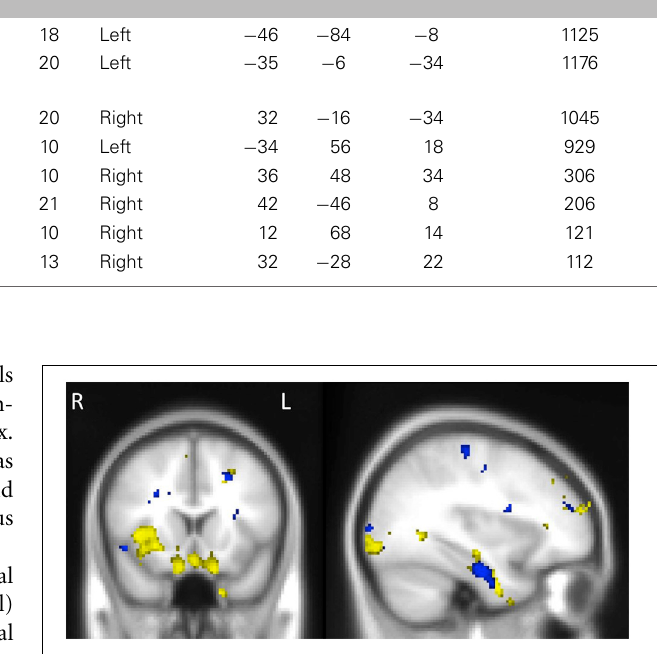
FIGURE 5 | Voxel-based morphometry results showing regions that correlate with emotional enhancement of memory in bvFTD (yellow) and AD (blue). Colored voxels show regions that were significant in the analyses p < 0 . 005 uncorrected for multiple comparisons. Clusters are overlaid on the standard Montreal Neurological Institute (MNI) brain. MNI Coordinates: x = − 34, y = 16, z = − 22. All clusters reported t >